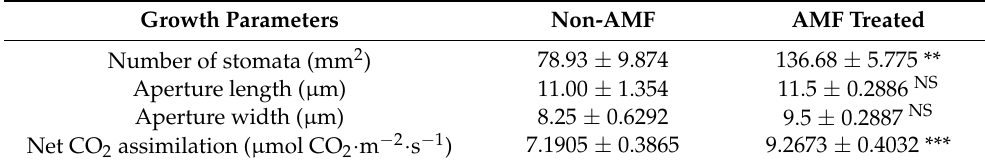
Table 1. Stoma density, leaf gas exchange and pigments, and vegetative growth characteristics of Philodendron bipinnatifidum in response to arbuscular mycorrhizal fungi after 8 weeks acclimatization. Growth